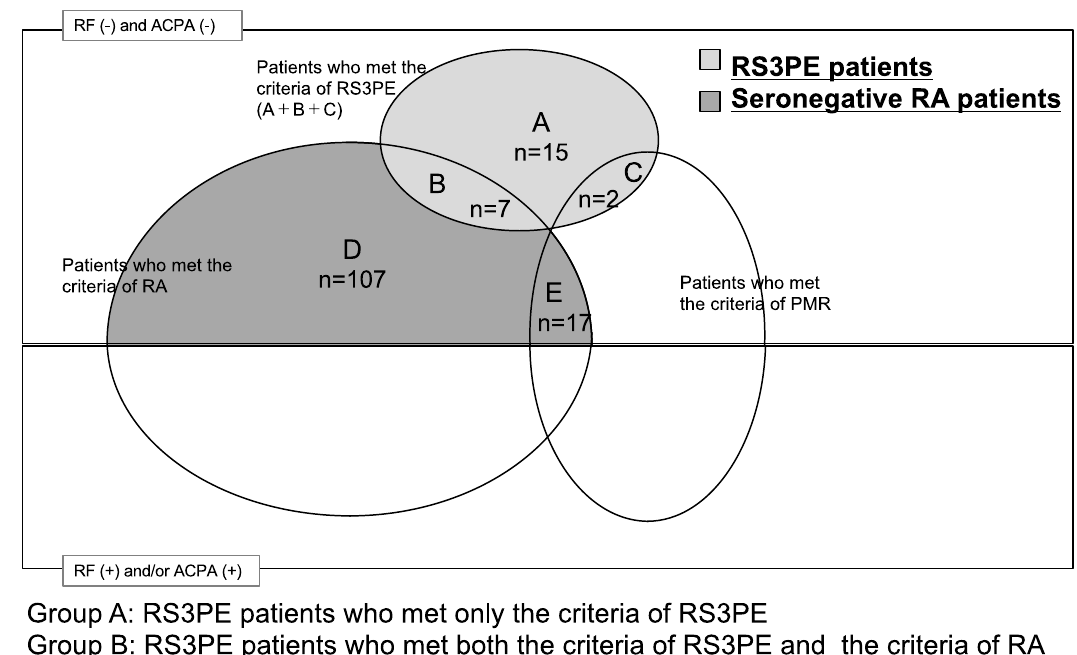
Figure 1. Diagnostic criteria for RS3PE and seronegative RA, as used in this study. Patients in Group A met only the criteria for RS3PE. Patients in Group B met the criteria for both RS3PE and RA. Patients in Group C met the criteria for both RS3PE and PMR. Patients in Group D met only the criteria for RA. Patients in Group E met the criteria for both RA and PMR. The RS3PE group consisted of Group A + B + C patients. The seronegative RA group consisted of Group D + E patients. No patients met the criteria for RS3PE, RA, and PMR. ACPA, anti-cyclic citrullinated peptide antibody; PMR, polymyalgia rheumatica; RA, rheumatoid arthritis; RF, rheumatoid factor; RS3PE, remitting seronegative symmetrical synovitis.